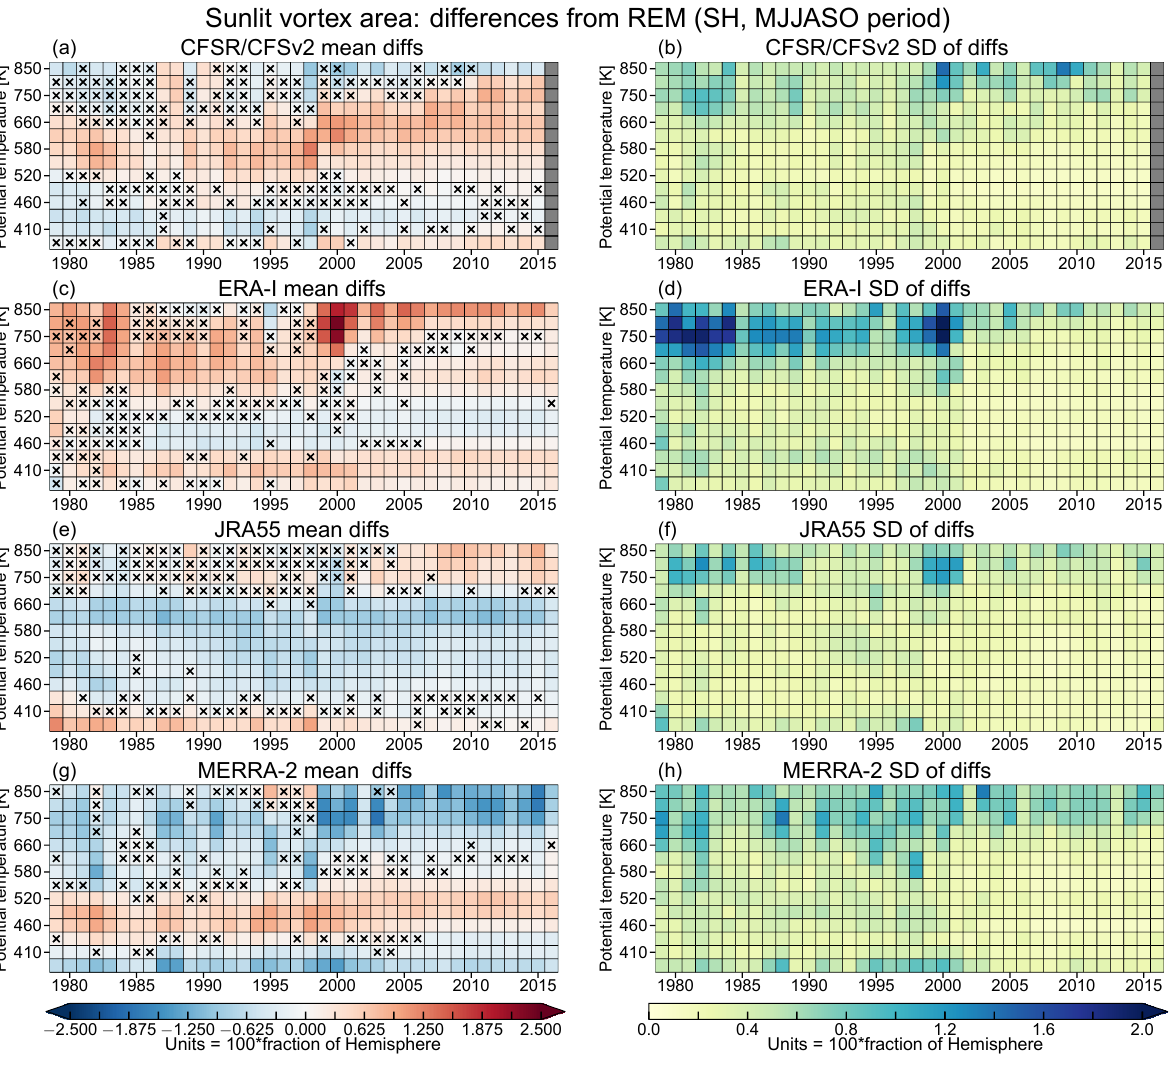
Figure 13. As in Fig. 4 but for SH sunlit vortex